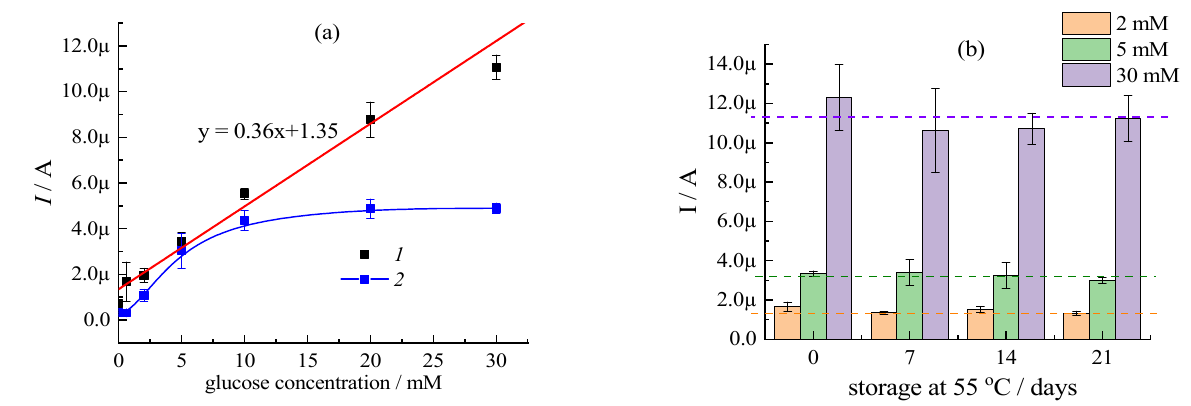
Figure 7. ( a )–Calibration curves obtained from glucose test-strips modified by 10 mg/mL of CMC, 25 mg/mL of ALG, 25 mg/mL of PD and 1 mg/mL of GOx in CitB, pH 6 (1) and in AcB, pH 5.5 (2) ( b )–Storage stability of test-strips with 10CMC/25ALG/25PD/24GOx in CitB, pH 6.